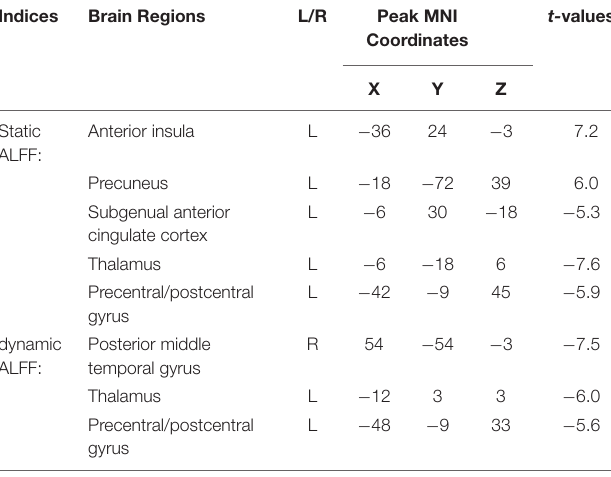
TABLE 2 | Regions with changed static and dynamic ALFF in CDP